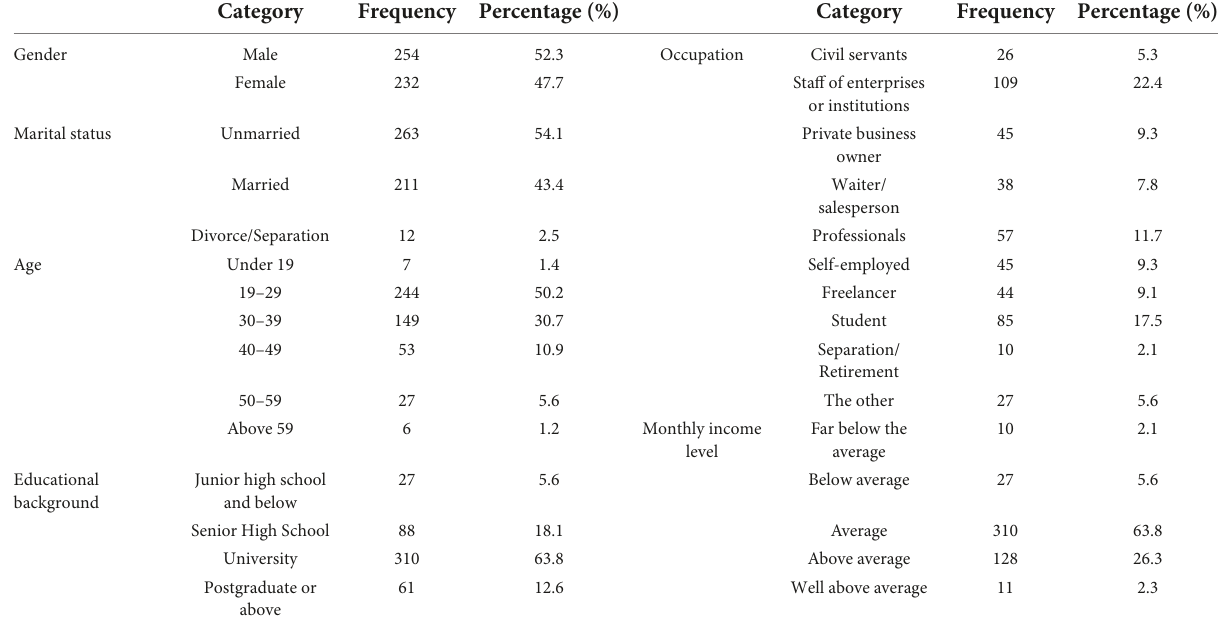
TABLE 2 Demographic characteristics of